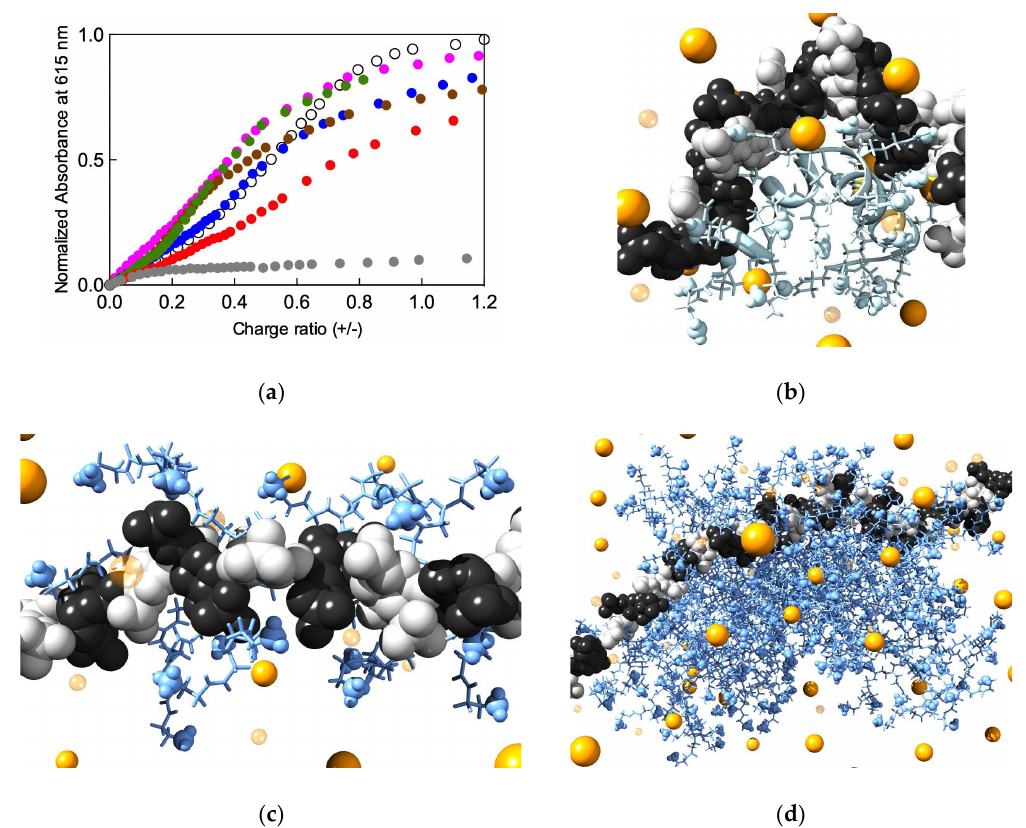
Figure 2. ( a ) Heparin binding curves of protamine (black empty symbols) and EDA-core PAMAM dendrimers from G 0 to G 6 (colored filled symbols) obtained from the Mallard Blue (MB) dye displacement assay performed in buffer (10 mM Tris HCl, pH 7.4) containing 150 mM NaCl. Color legend: Gray, G 0 ; red, G 1 , green, G 2 , brown, G 3 , blue, G 4 , and pink, G 6 ). The binder concentration on the x-axis is expressed in terms of binder/heparin charge ratio, in which the average negative charge of the heparin disaccharide unit is taken equal to the ideal value of −4. The different binder charges are listed in the second column of Table A1. Equilibrated MD (Molecular Dynamics) simulation images of ( b ) protamine, ( c ) G 2 , and ( d ) G 6 EDA-core PAMAM dendrimers in complex with heparin. In all panels, heparin is shown as white (D-glucosamine) and black (L-iduronic acid) spheres, while protamine and dendrimers are portrayed as light blue sticks, with the positively-charged groups highlighted as spheres. Some Na + and Cl − used as counterions and to mimic the 150 mM ionic strength in solution are shown as small and large yellow spheres, respectively. Water molecules are omitted for clarity. Adapted from [33] with the permission of The Royal Society of Chemistry.